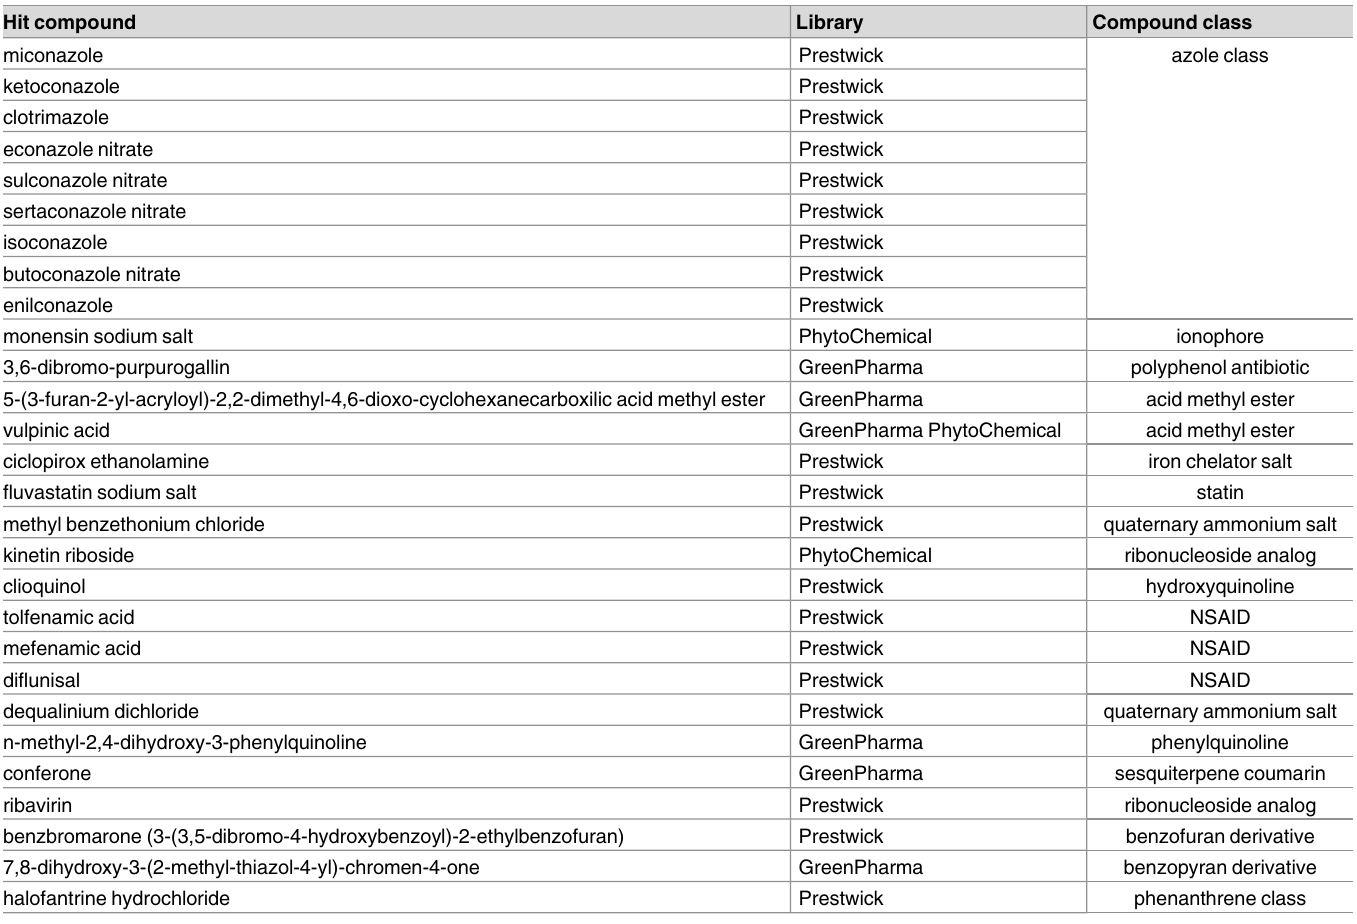
Table 1. List of VDA